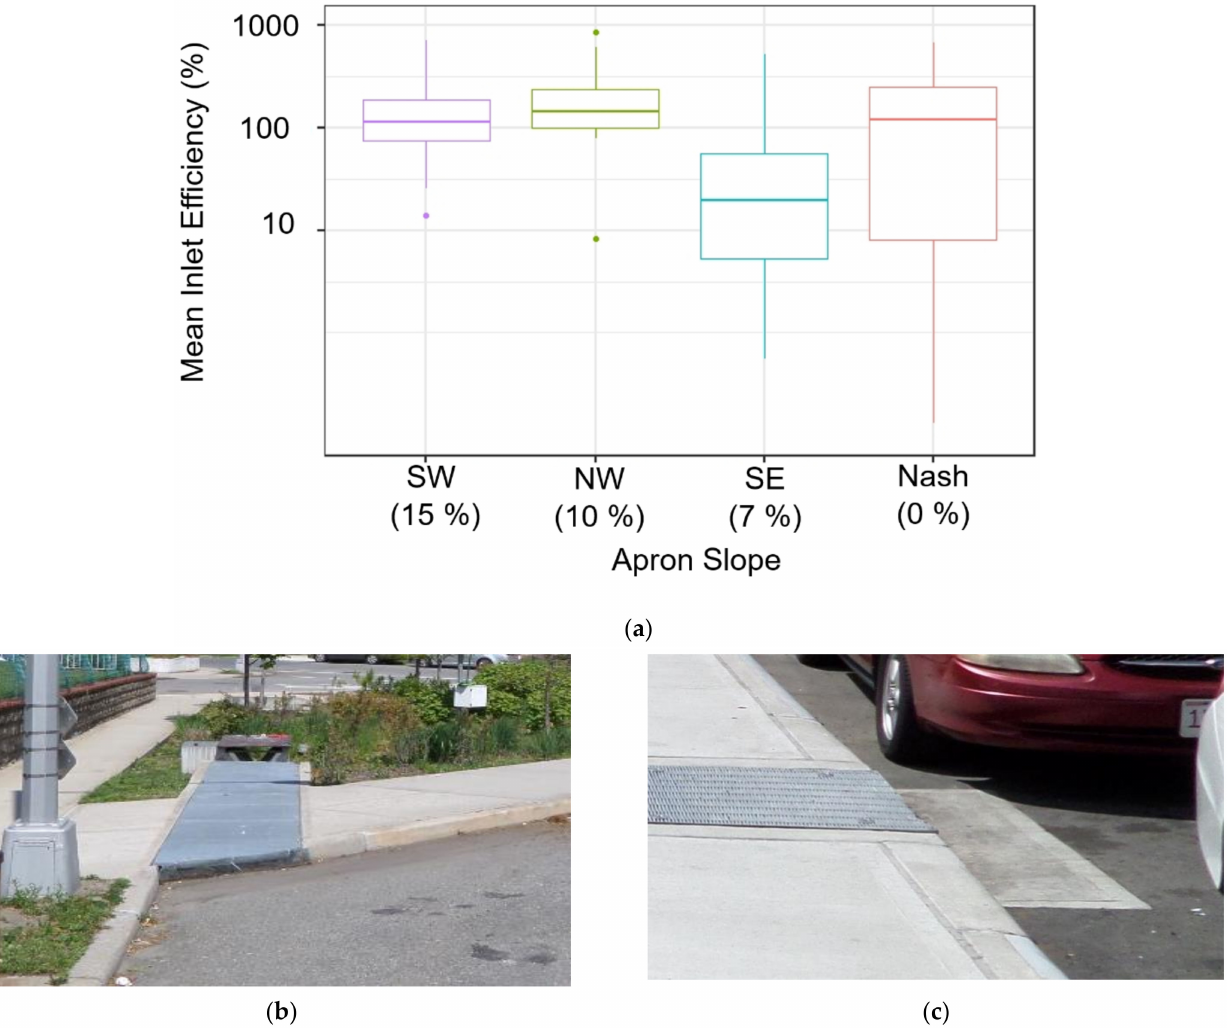
Figure 9. ( a ) Effect of apron slope on mean inlet efficiency of inlets; ( b ) photograph depicting apron conditions at Nashville inlet—0% design apron slope; ( c ) photograph depicting apron conditions at SW inlet—10% design apron